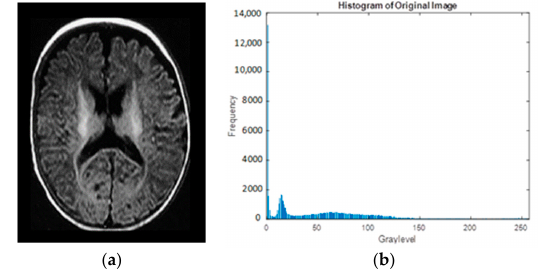
Figure 7. ( a ) Original Image; ( b ) Histogram Image.